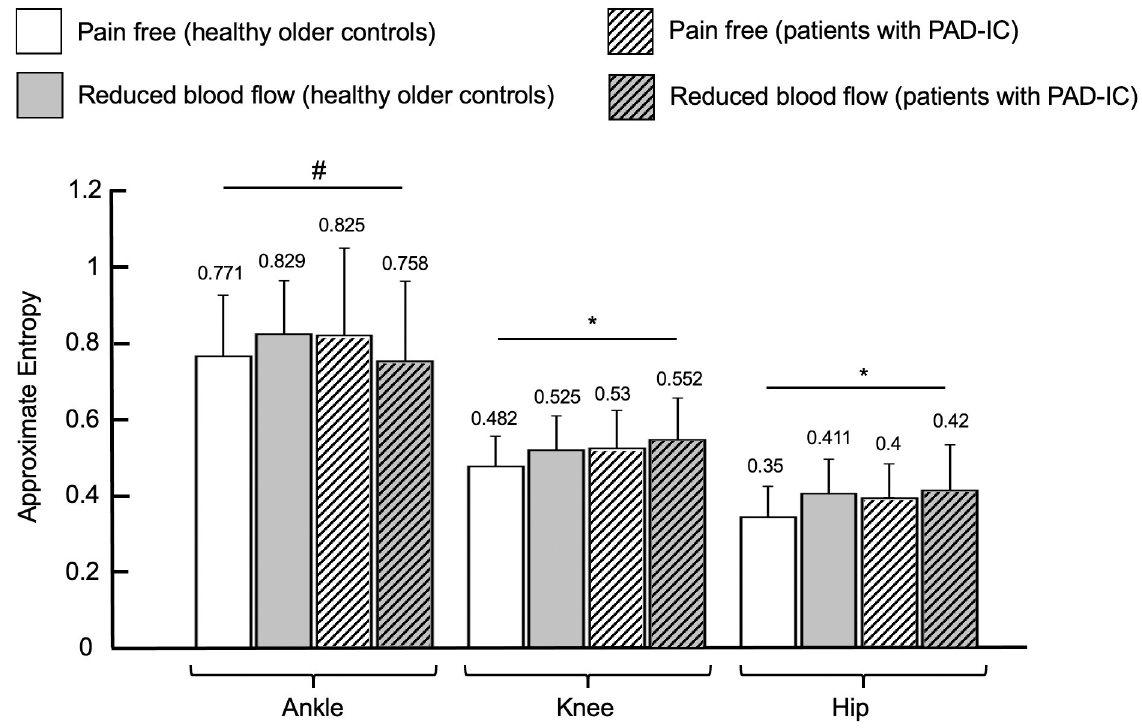
Fig 4. Approximate entropy values for healthy older controls and for patients with Peripheral Artery Disease with Intermittent Claudication (PAD-IC) in the pain free and reduced blood flow conditions for ankle, knee, and hip ranges of motion. � indicates significant differences between conditions (pain free vs. reduced blood flow, p < 0.05). + indicates significant differences between groups (healthy older controls vs PAD-IC, p < 0.05). # indicates post-hoc tests where significant interaction exists between groups and conditions. Bar graphs represent the mean values and error bars represent the standard deviation. Mean value for each bar was mentioned at the top of the corresponding error bar.